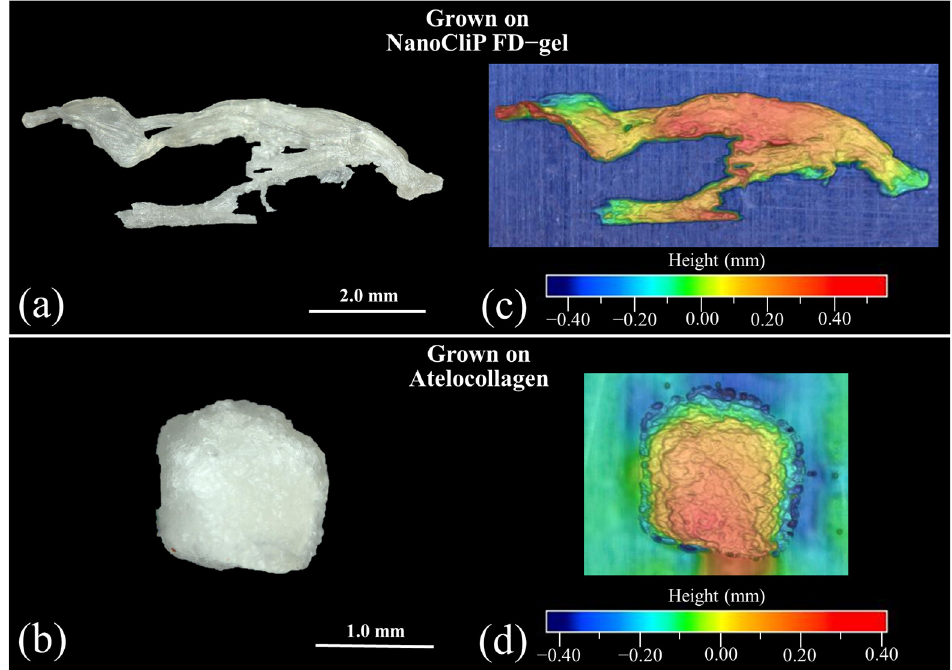
Figure 1. Laser microscope images of cartilage tissue formed after culturing for 14 days onto ( a ) NanoCliP-FD and ( b ) atelocollagen scaffolds; ( c , d ) represent their respective 3D views. The cell-grown cartilage matrix was then stained using Safranin O stain and Picrosirius red stain in order to perform a histological evaluation. In a cartilage-inducing medium, NanoCliP-FD gel (Figure 2a,c for Safranin O and Picrosirius Red, respectively) had a deeper reddish-purple hue and a greater amount of cartilage matrix compared to atelocollagen (Figure 2b,d for Safranin O and Picrosirius red, respectively). In normal medium-based cultures, no dark stains were observed in either atelocollagen or NanoCliP-FD gel